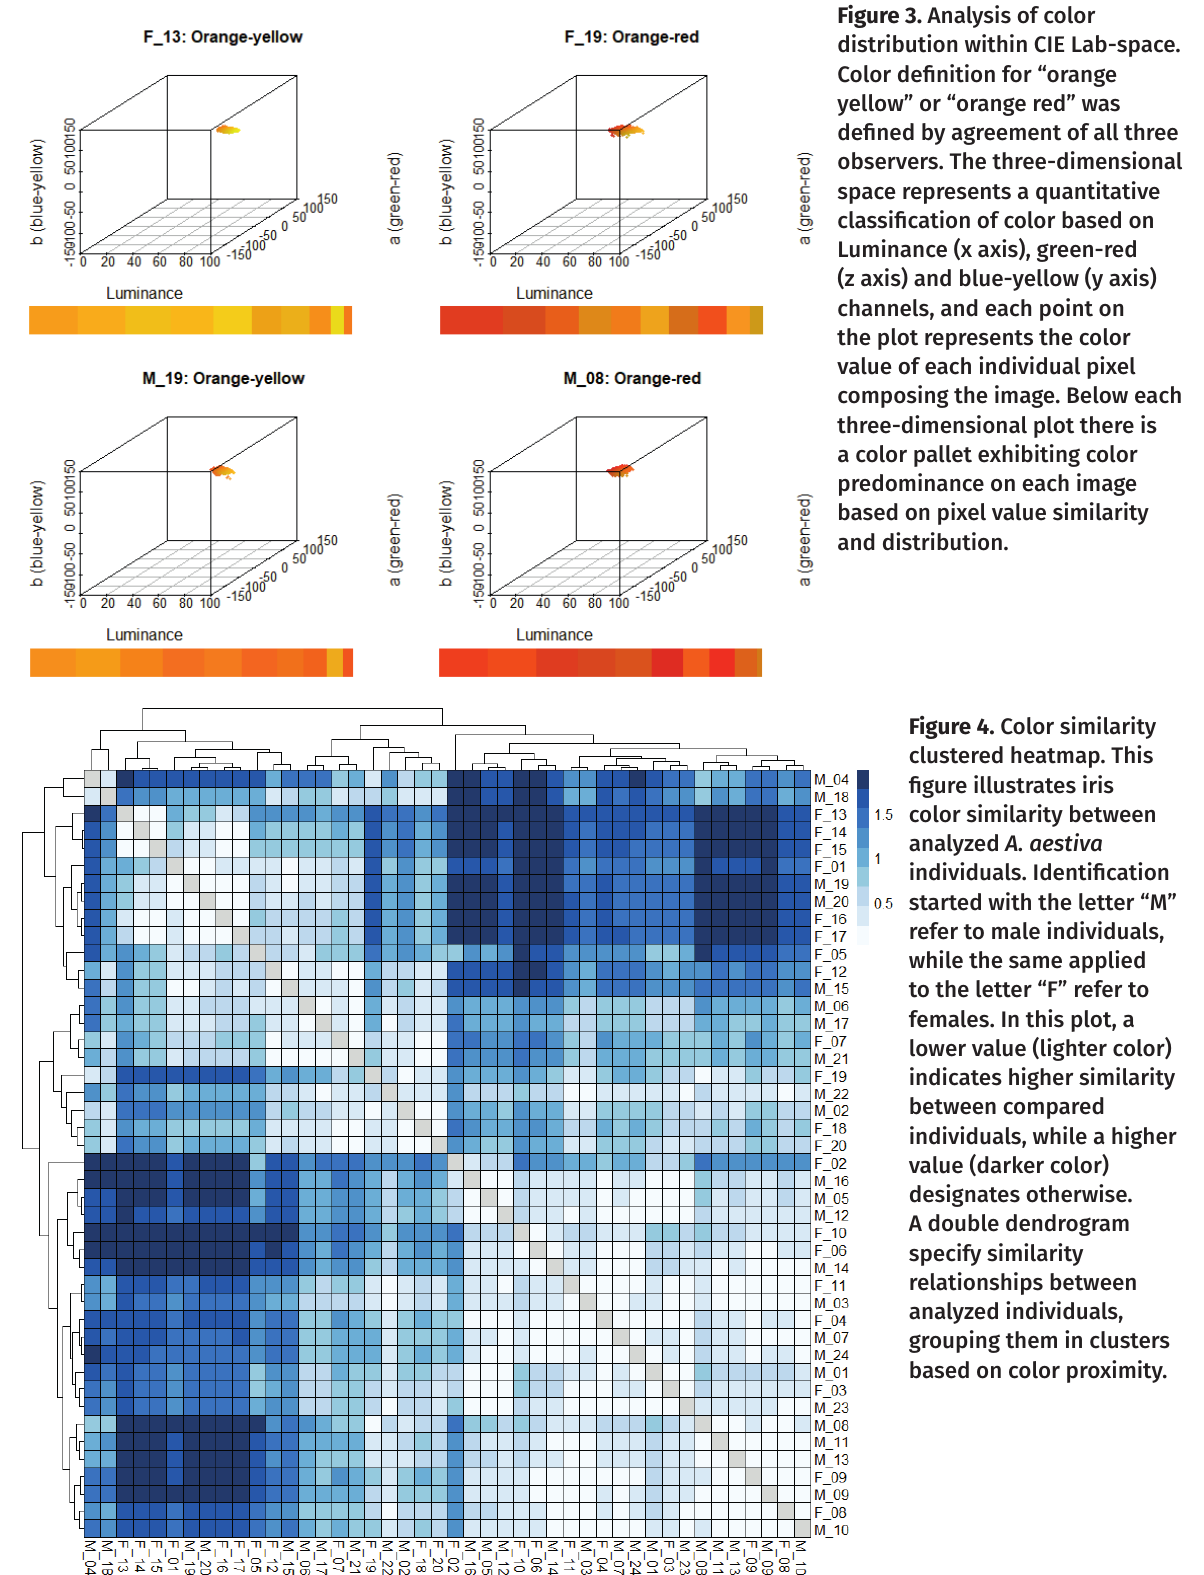
Figure 3. Analysis of color distribution within CIE Lab-space. Color defi nition for “orange yellow” or “orange red” was defi ned by agreement of all three observers. The three-dimensional space represents a quantitative classifi cation of color based on Luminance (x axis), green-red (z axis) and blue-yellow (y axis) channels, and each point on the plot represents the color value of each individual pixel composing the image. Below each three-dimensional plot there is a color pallet exhibiting color predominance on each image based on pixel value similarity and distribution.